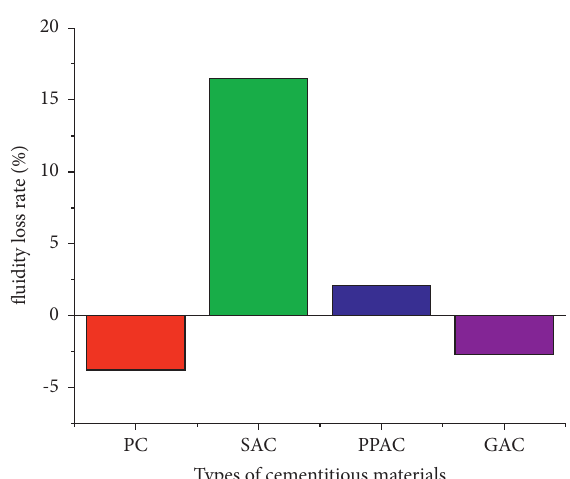
Figure 9: Loss rate of net slurry fluidity at saturation point after the initial time 60s.